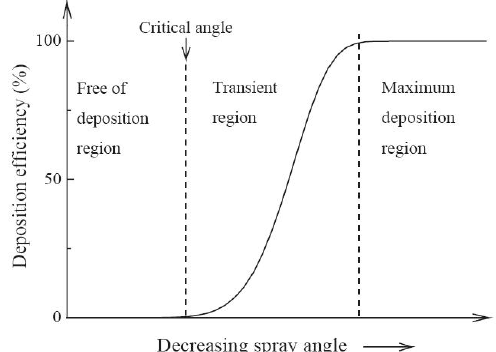
Figure 13: Effect of spray angle on deposition efficiency (DE)